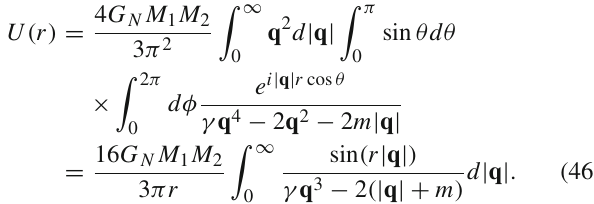
of the three-dimensional softly massive gravity.